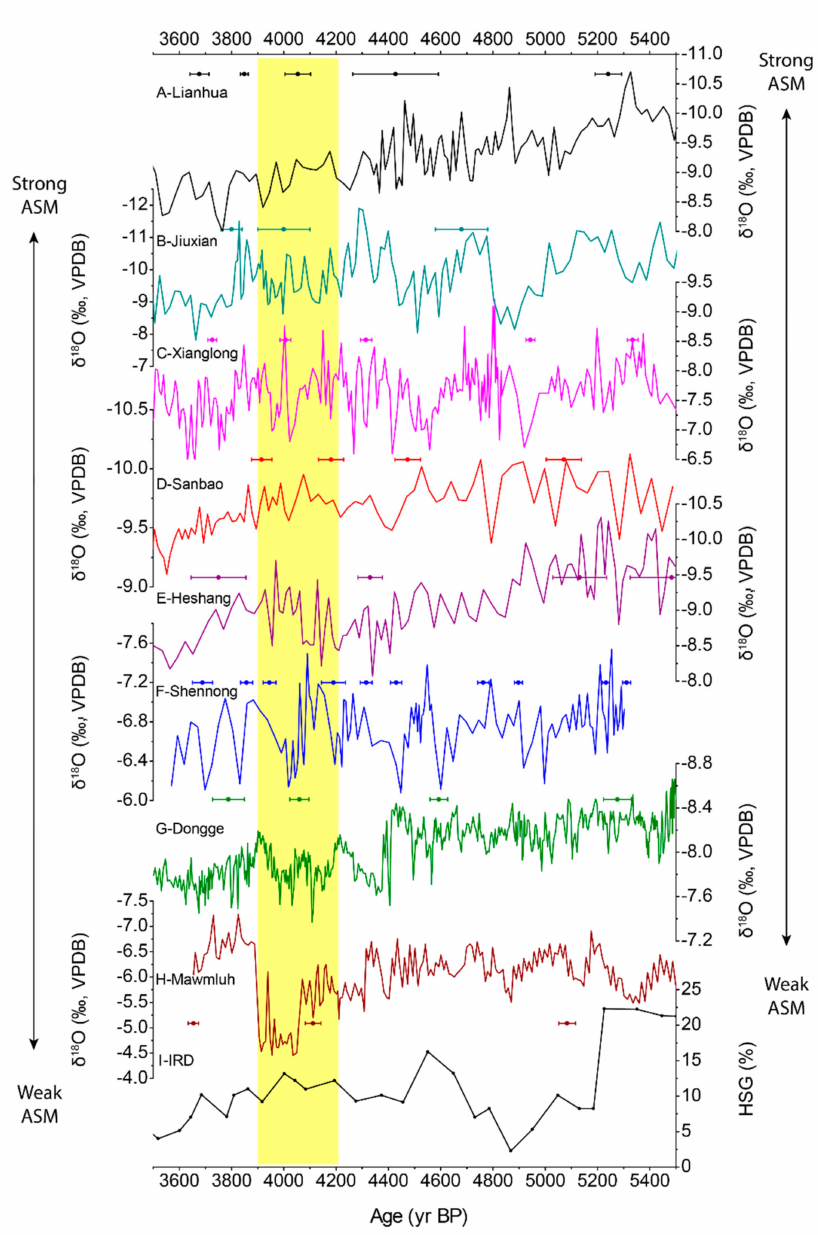
Figure 8. Speleothem δ 18 O records for the period 5500–3500 yr BP. ( A ) Lianhua Cave (Shanxi) [82]; ( B ) Jiuxian Cave [75]; ( C ) Xianglong Cave [151]; ( D ) Sanbao Cave [113]; ( E ) Heshang Cave [15]; ( F ) Shennong Cave [122]; ( G ) Dongge Cave [8]; ( H ) Mawmluh Cave [230] and ( I ) the ice-rafted hematite-stained grains (HSG) record from the North Atlantic [231]. 230 Th dates and error bars are shown at the top of each speleothem δ 18 O time-series. The yellow bar marks the interval 4.2-3.9 kyr